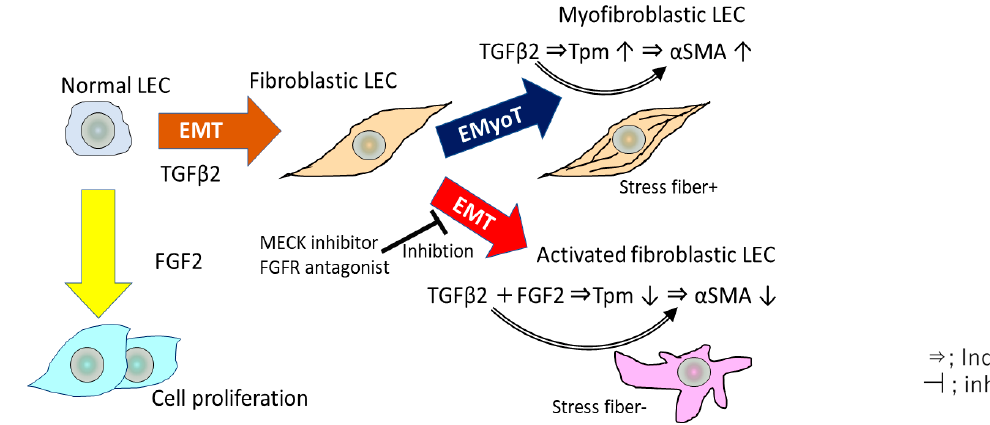
Figure 3. Overview of EMT and EMyoT induction in LECs by TGF β 2 and FGF2. TGF β induces EMyoT and Tpm expression. Tpms promote the formation of stress fibers undergoing EMyoT. FGF2 suppresses the TGF β 2-induced over-expression of Tpms. Depletion of Tpms by FGF suppresses the formation of stress fibers and activates fibroblastic LECs, which lose cell polarity, inducing cell migration.